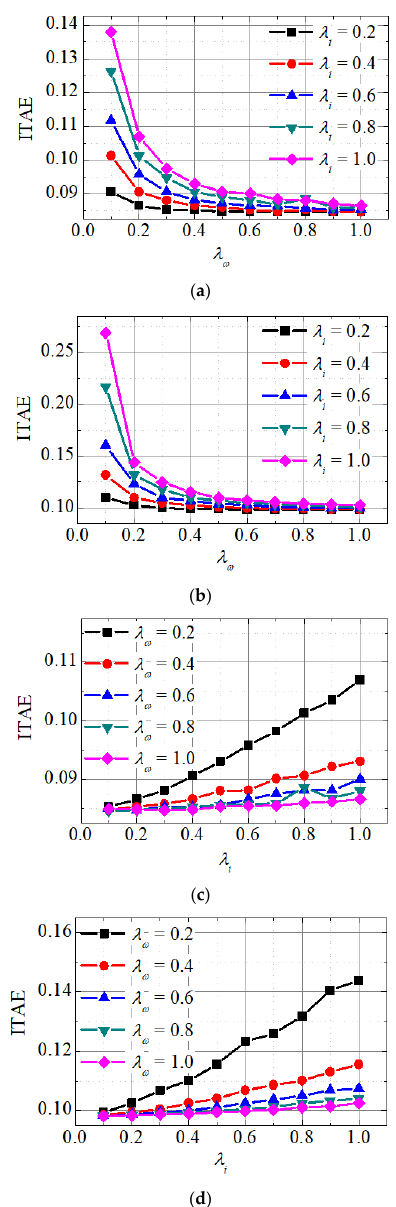
Figure 8. Contour maps of rotor position ITAEs with different weighting factors for the conventional NMPSC and the NMPSC with the proposed method. ( a ) λ ω to ITAE for the NMPSC with AAVE method; ( b ) λ ω to ITAE for the conventional NMPSC; ( c ) λ i to ITAE for the NMPSC with AAVE method; ( d ) λ i to ITAE for the conventional NMPSC.